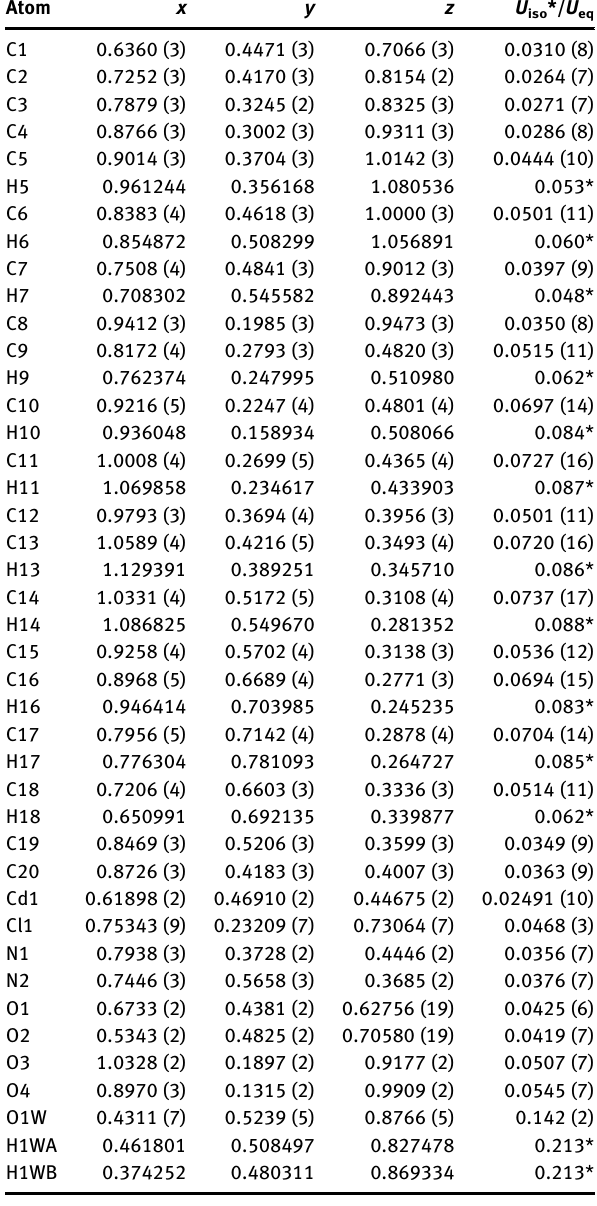
Table  : Fractional atomic coordinates and isotropic or equivalent isotropic displacement parameters (Å 